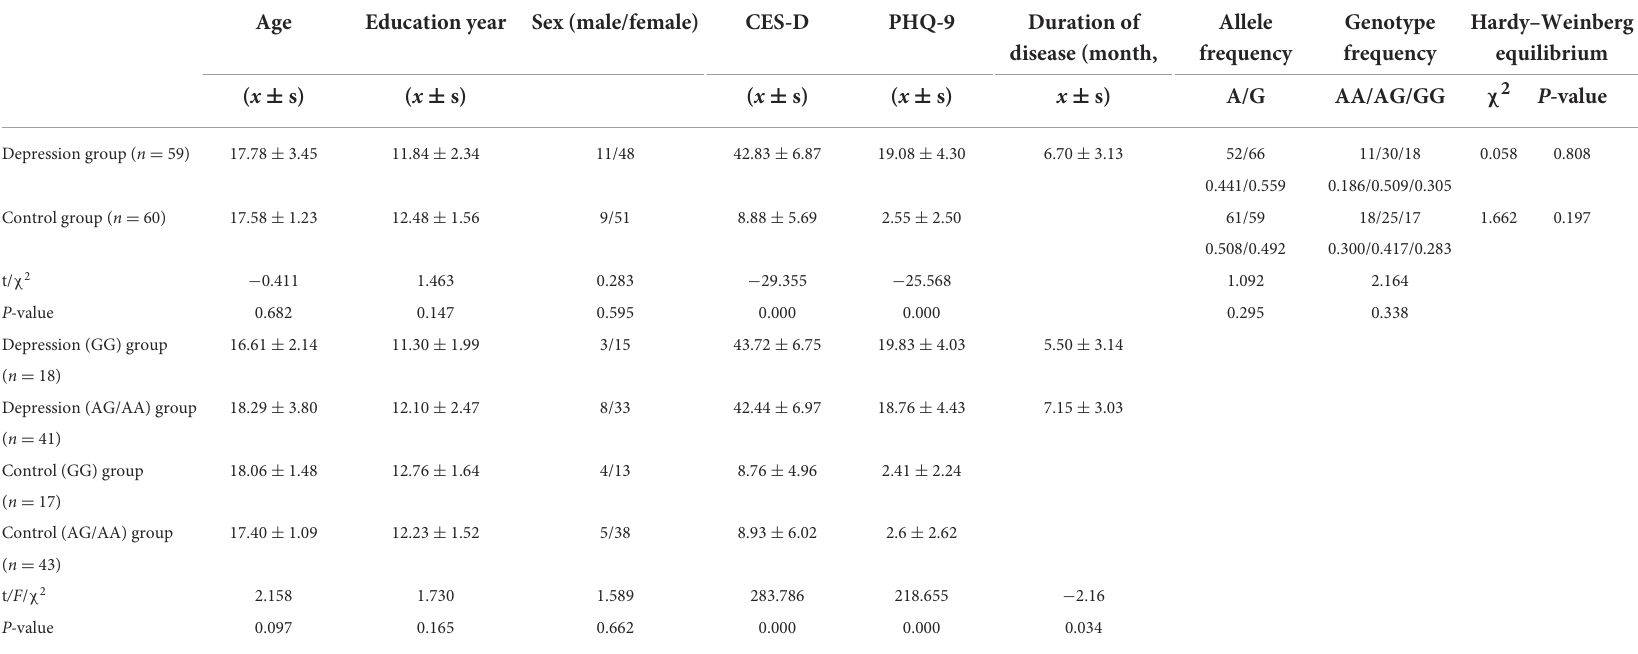
TABLE 1 Descriptive characteristics and genotyping data of the depression and control